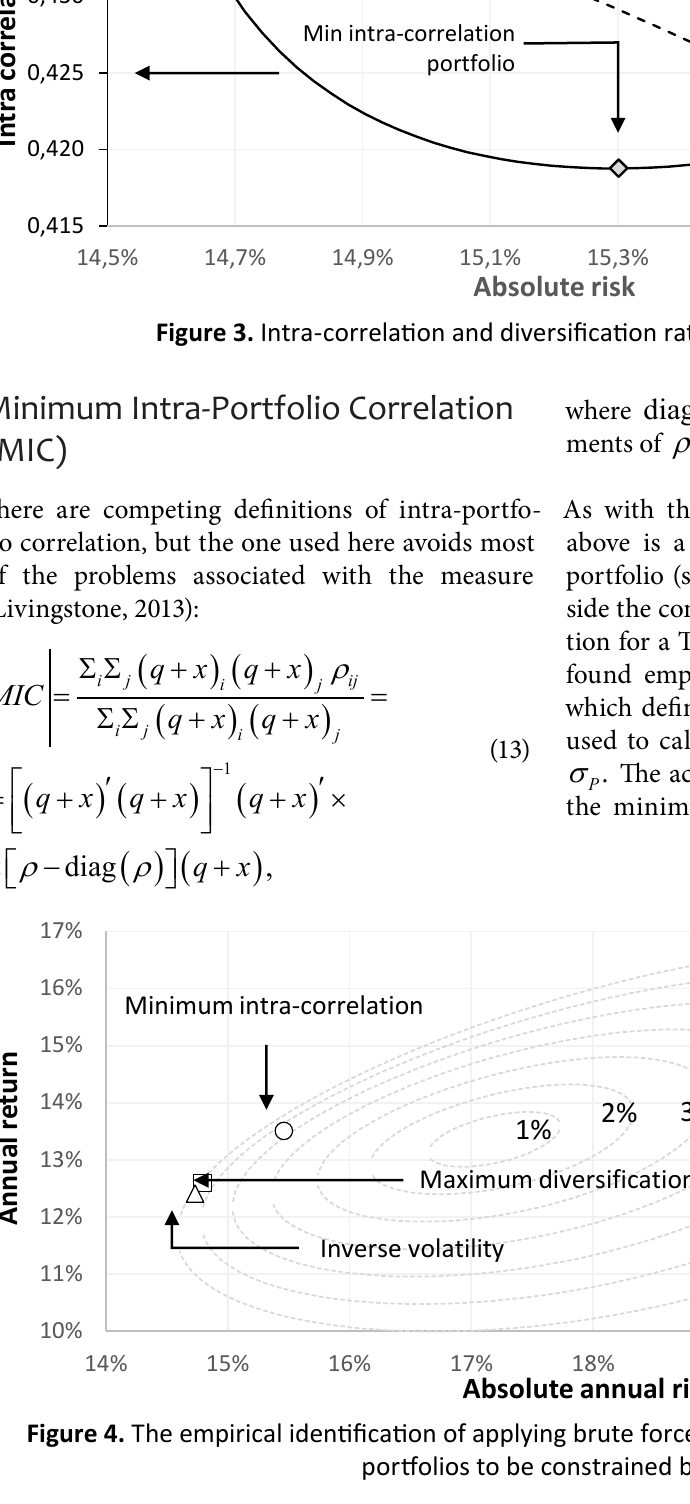
Figure 4. The empirical identification of applying brute force mathematics on the MD and MIC portfolios to be constrained by TE